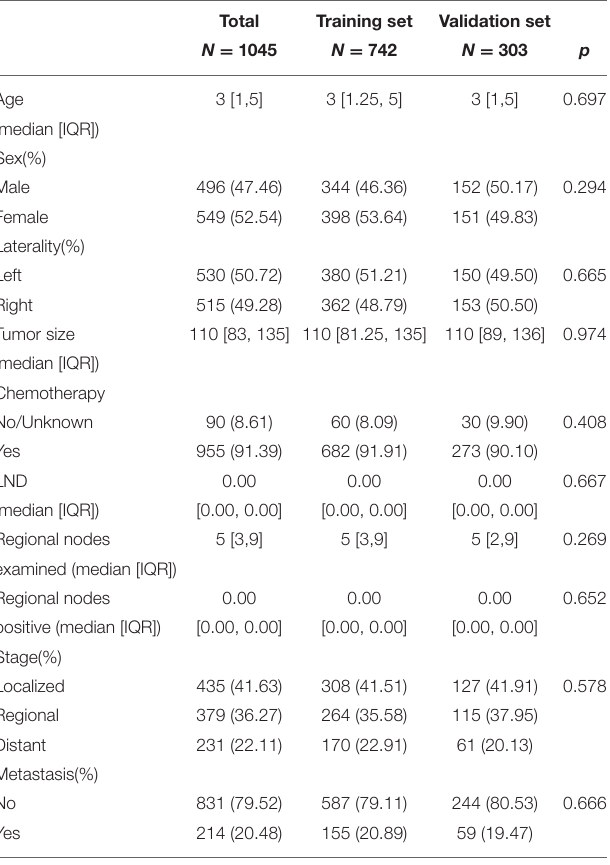
TABLE 2 | Clinicopathological characteristics of children with WT in SEER cohort and CHCMU. Total SEER cohort CHCMU